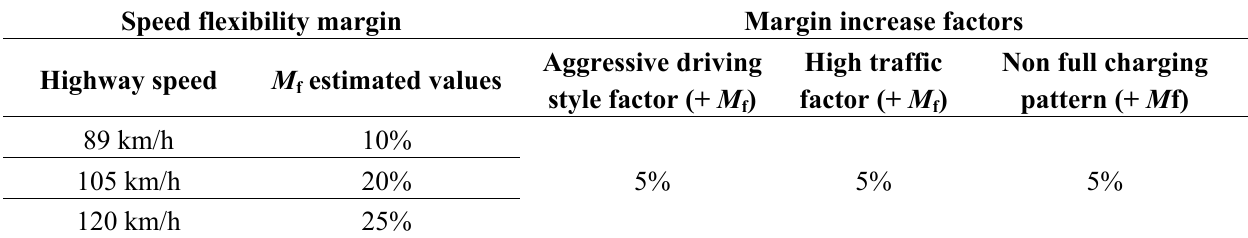
Table 4. Flexibility margin estimated values and